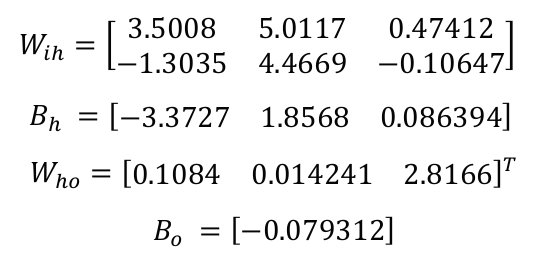
Figure 9. Variation of mean squared error with training epochs.